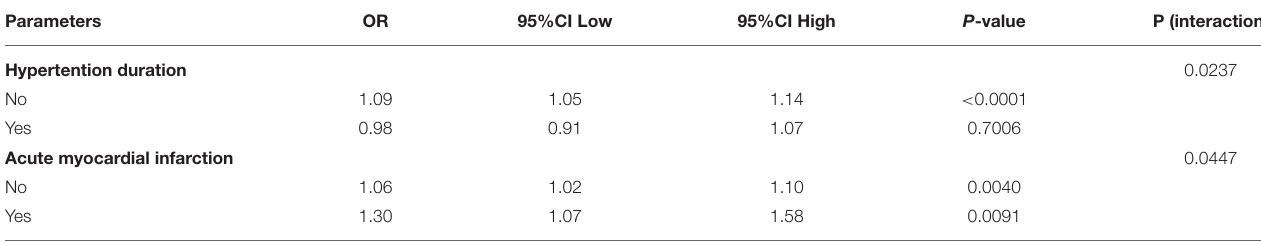
TABLE 3 | Subgroup analysis by stratified binary logistic regression